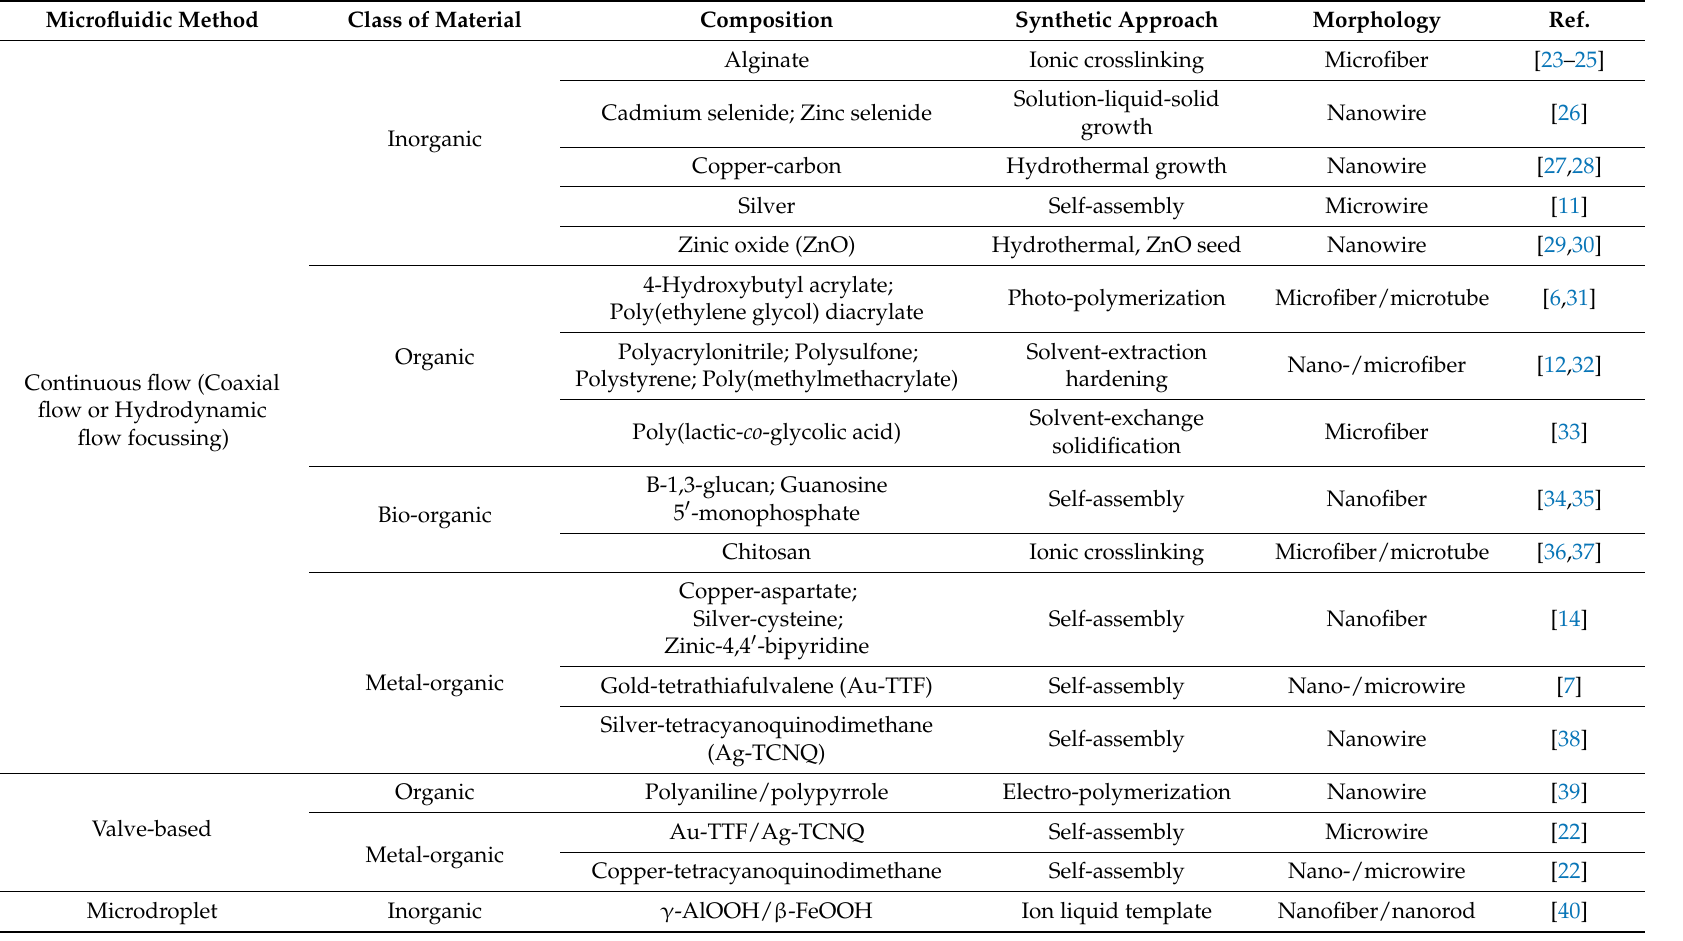
Table 1. Summary of selected microfluidic-synthesized 1D